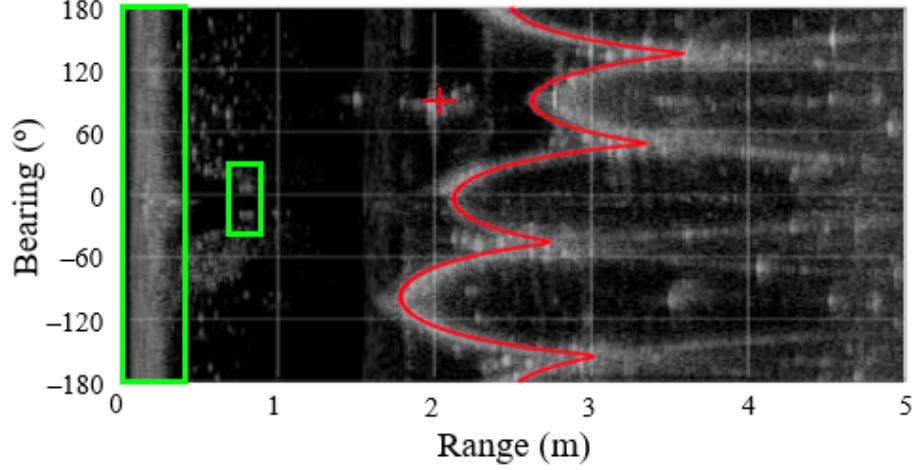
Figure 3. Acoustic image obtained through mechanical scanning imaging sonar from a water tank. The representation of the tank walls and a floater are marked in red. Reflections on the Autonomous Underwater Vehicle’s (AUV) body are highlighted in green.